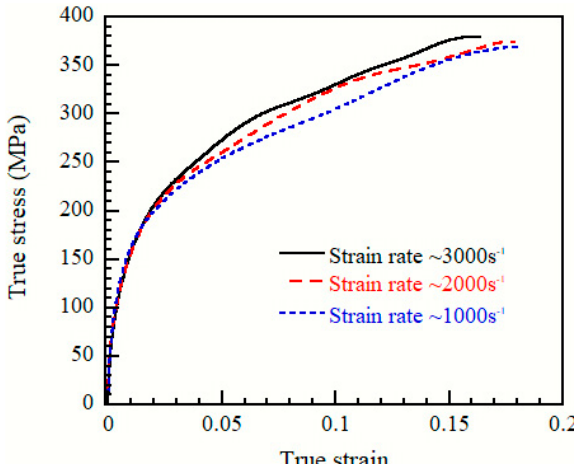
Figure 3. Transmission electron microscopy (TEM) bright field images and selected area electron diffraction (SAED) patterns of the long period stacking ordered (LPSO) phases in the as-cast Mg95.5Y3Zn1.5 alloy: ( a ) and ( b ) LPSO phase located at the grain boundaries; ( c ) and ( d ) LPSO lamellae located within the Mg matrix.